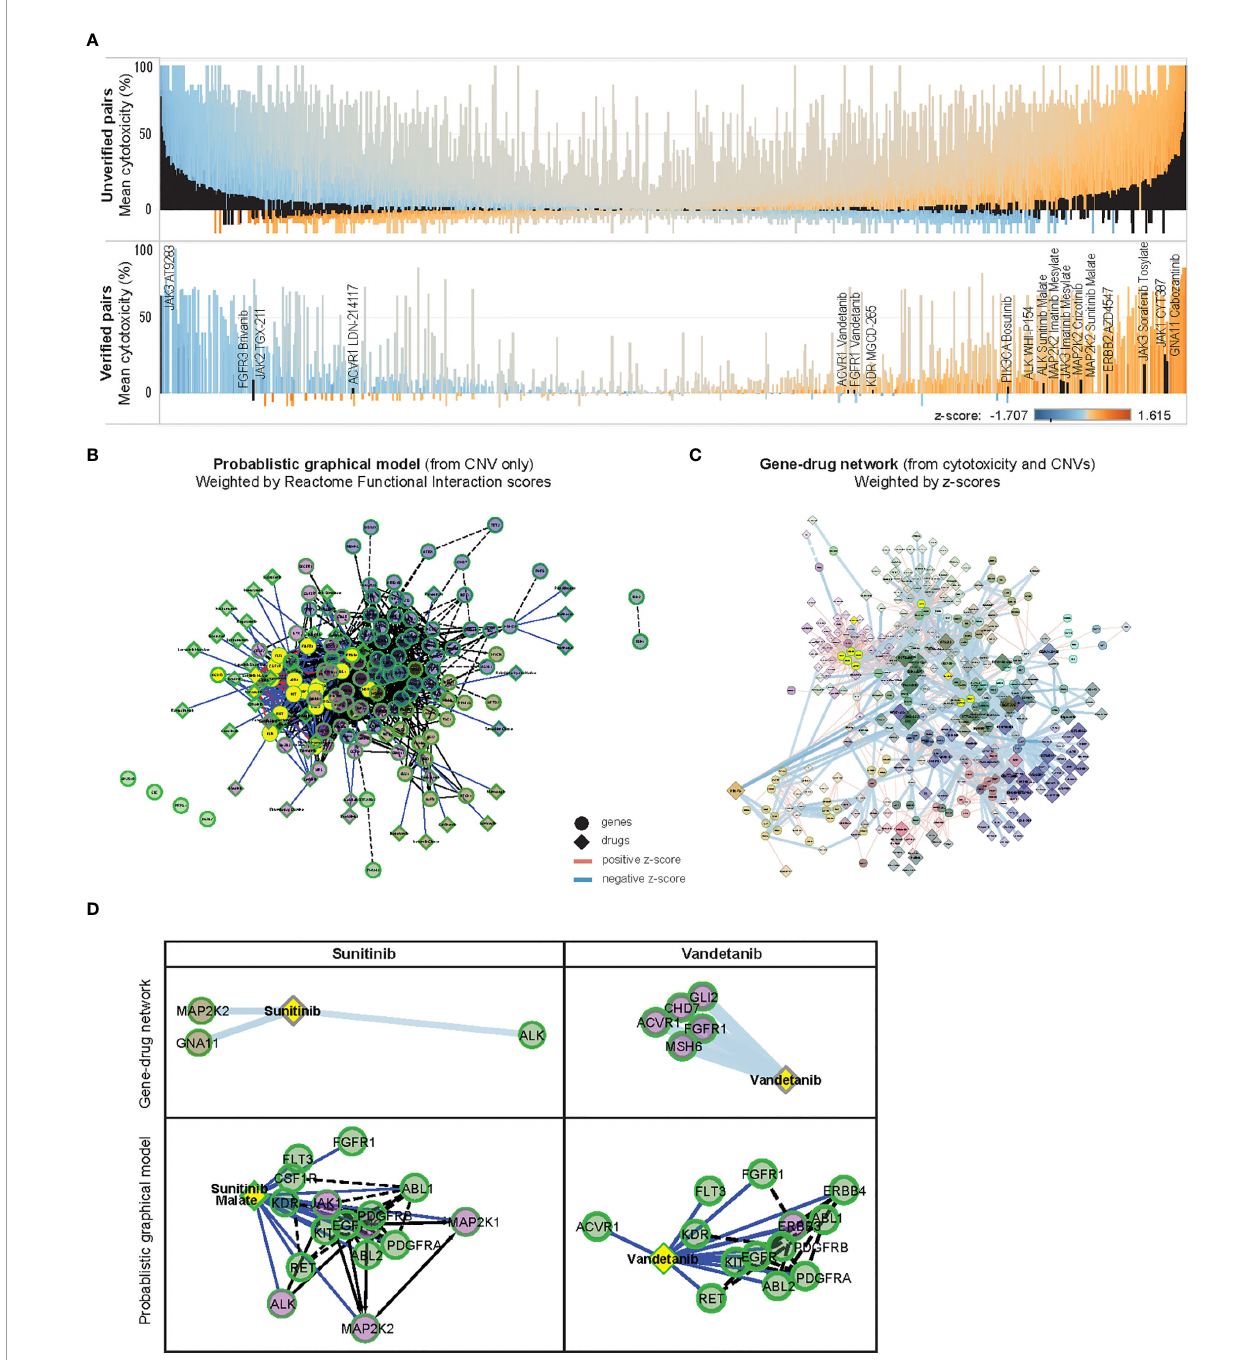
FIGURE 5 | In-silico validation of gene-drug pairs. (A) Parallel waterfall plots of the mean cytotoxicity of drugs unveri fi ed or veri fi ed in public datasets, ranked by the product of their z-scores and cytotoxicity; with similar distribution of z-scores and cytotoxicity are seen among both groups. Signi fi cantly correlated gene-drug pairs in each group are indicated in black [upper panel: 1259 of 55,543 unveri fi ed gene-drug pairs, lower panel: 19 of 1305 veri fi ed gene-drug pairs (total 54,758 gene- drug pairs)], color scale indicates z-scores. (B) ReactomeFIViz Probabilistic Graphical Model (PGM) constructed from weighted factors derived from CNV of 131 OCCRA genes in 13 neuroblastoma cases, annotated with 46 associated Cancer Targetome drugs and clustered according to Reactome Functional Interaction (FI) scores; solid links indicate known associations and dotted links indicate predicted association, nodes are colored according to Reactome FI clusters (C) z-score weighted network of 131 OCCRA genes and 418 drugs, clustered similarly according to Reactome FI scores; width of links indicates z-score and size of diamonds indicates cytotoxicity. (D) Association of sunitinib and vandetanib with fi rst-degree neighbor genes, determined by z-scores, and as predicted by PGM. Both sets of gene-drug pairs are correspondingly indicated in yellow in (B, C)